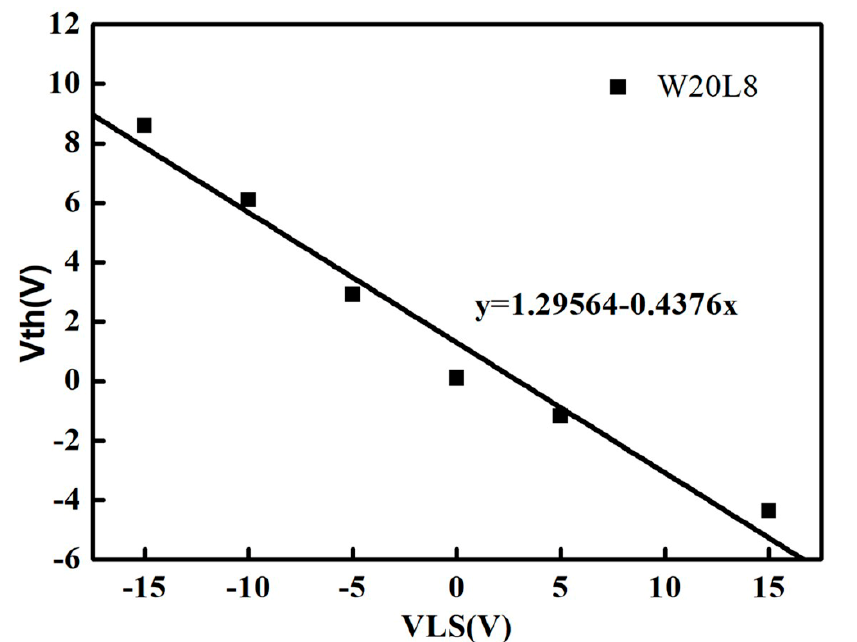
Figure 1. The cross-sectional diagram of dual-gated TFT.